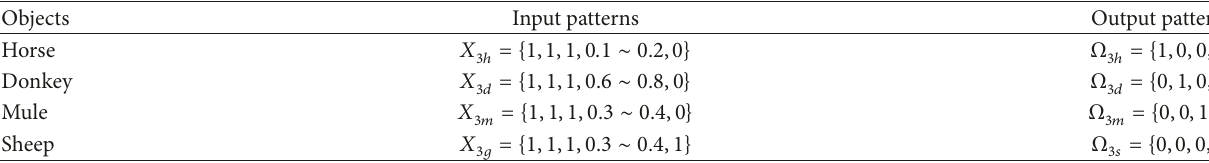
Table 3: Relationships of input/output patterns in